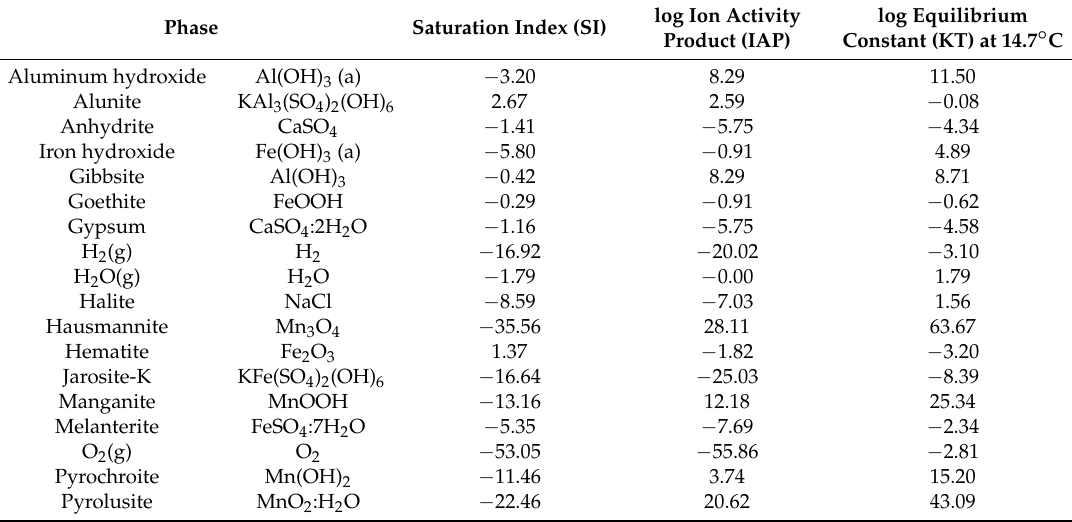
Table A2. Saturation state in San Francisco River 30 m after the confluence point (pH =